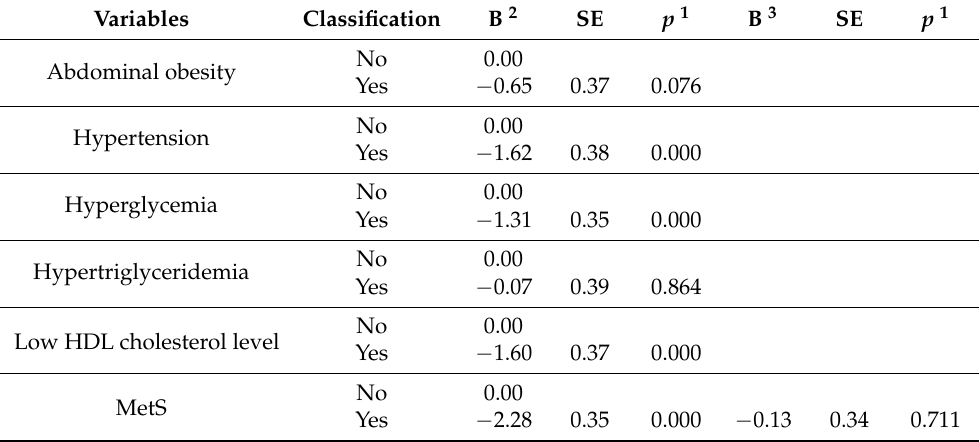
Table 3. The association between MetS and the number of remaining